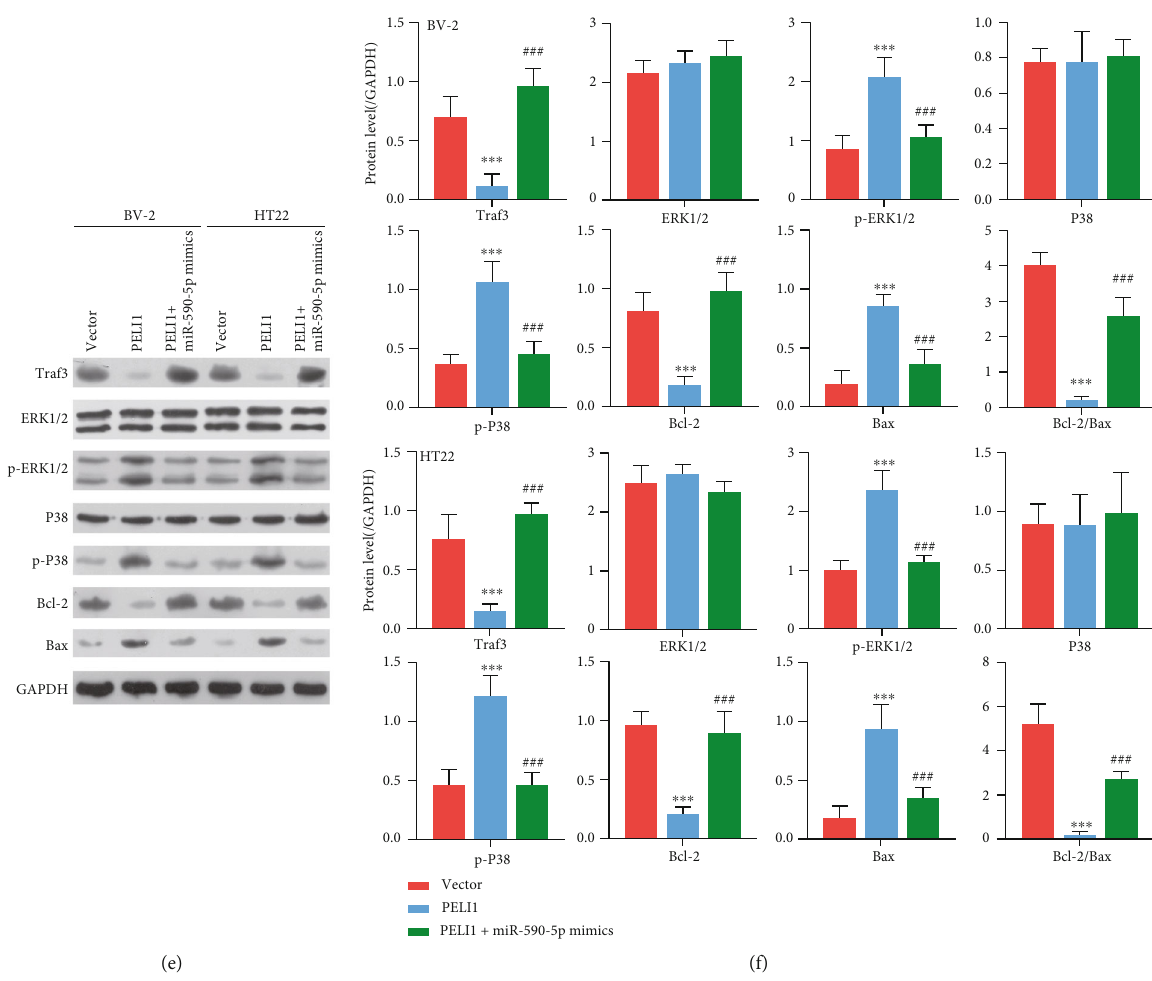
Figure 6: E ff ect of miR-590-5p silence on BV-2 and HT22 cells was regulated by PELI1. (a, b) The mRNA and protein levels of PELI1 in BV-2 or HT22 cells treated with vector, PELI1 (overexpression of PELI1 CDS+3 ′ UTR), and PELI1 (overexpression of PELI1 CDS+3 ′ UTR)+miR-590-5p mimics, respectively, by qPCR and western blotting. (c, d) Cell viability of BV-2 or HT22 cells treated with vector, PELI1, and PELI1+miR-590-5p mimics, respectively, by CCK-8 assay. (e) The cell apoptosis of BV-2 or HT22 cells treated with vector, PELI1, and PELI1+miR-590-5p mimics, respectively, by TUNEL assay (blue, nucleus; green, TUNEL-positive cells). (f) The expression of Traf3, phosphorylation levels of ERK1/2 and P38, and apoptosis-related proteins (Bcl-2 and Bax) in BV-2 or HT22 cells treated with vector, PELI1, and PELI1+miR-590-5p mimics, respectively, by western blotting. Each experiment was repeated three times. ∗∗∗ P < 0 : 001 vs. vector group; ### P < 0 : 001 vs. PELI1